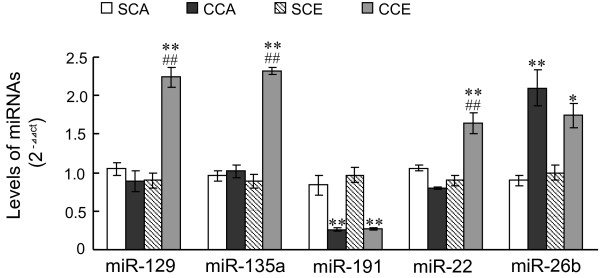
Levels of five miRNAs in rat hippocampus by qRT-PCR. Values are mean ± SD. Repeated cocaine-exposed rats that acquired cocaine CPP serves as “CCA” group, and repeated saline-exposed rats serves as SCA control. The cocaine CPP-extinguished rats serves as CCE group, and rats with saline CPP and subsequent extinction trainings serves as SCE control. n = 3 samples/12 rats per group. **p < 0.01, *p < 0.05 vs. controls (SCA or SCE rats). ##p < 0.01 vs. CCA rats.